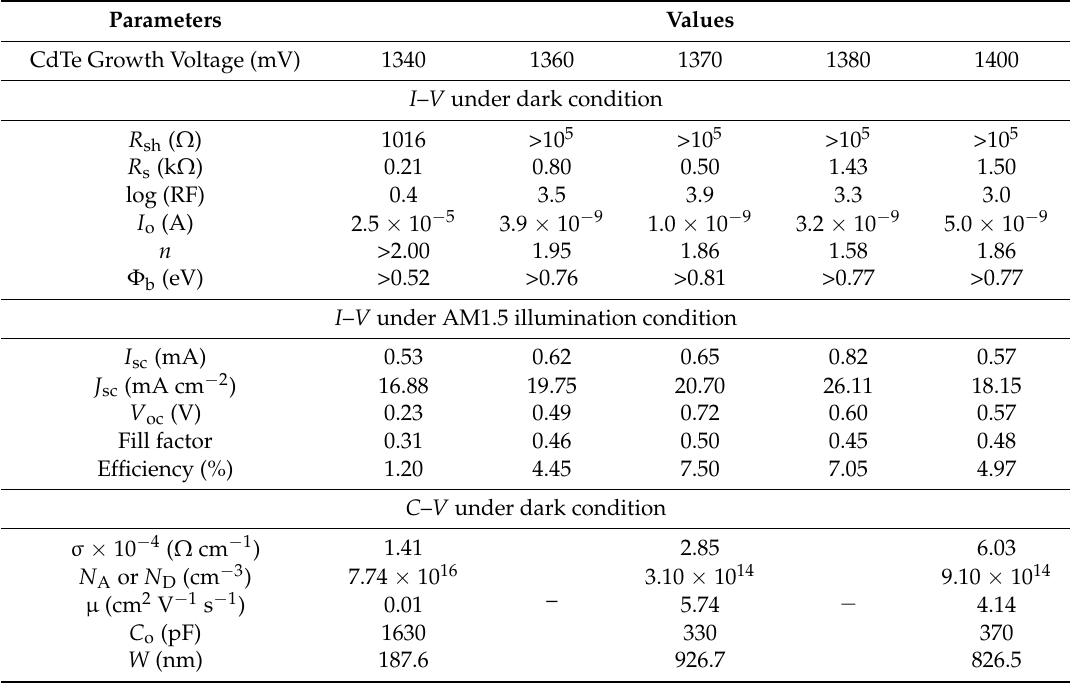
Table 2. Summary of device parameters obtained from I – V (both under illuminated and dark conditions) and C – V (dark condition) for simple CdS/CdTe-based solar cells grown at different growth voltages in the vicinity of V i = 1370